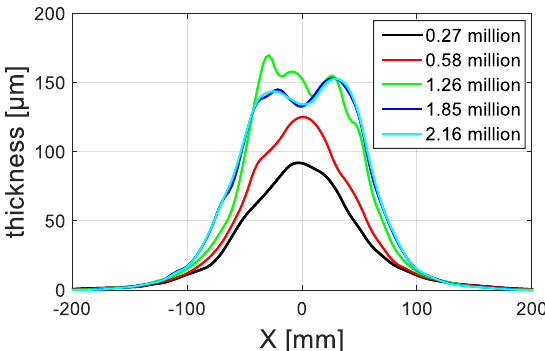
Figure 4. Comparison of coating thickness distribution along the x -axis for five kinds of grids, with 0.27, 0.58, 1.26, 1.85, and 2.16 million cells.